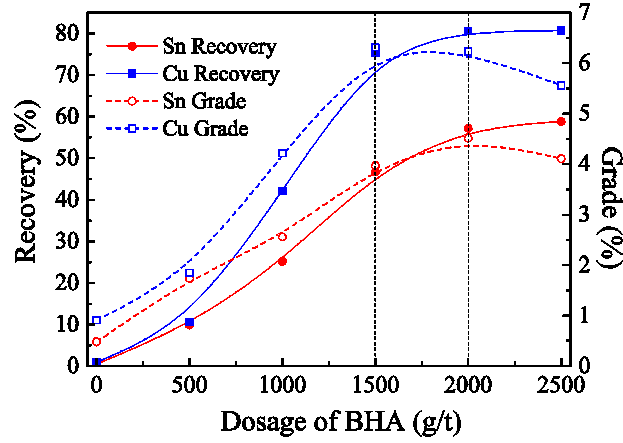
Figure 8. Flotation recovery and grade of Sn and Cu as a function of the dosage of BHA (pH = 7.2–7.5; CMC 350 g/t; SSF 250 g/t; lead nitrate 200 g/t; terpineol 25 g/t).